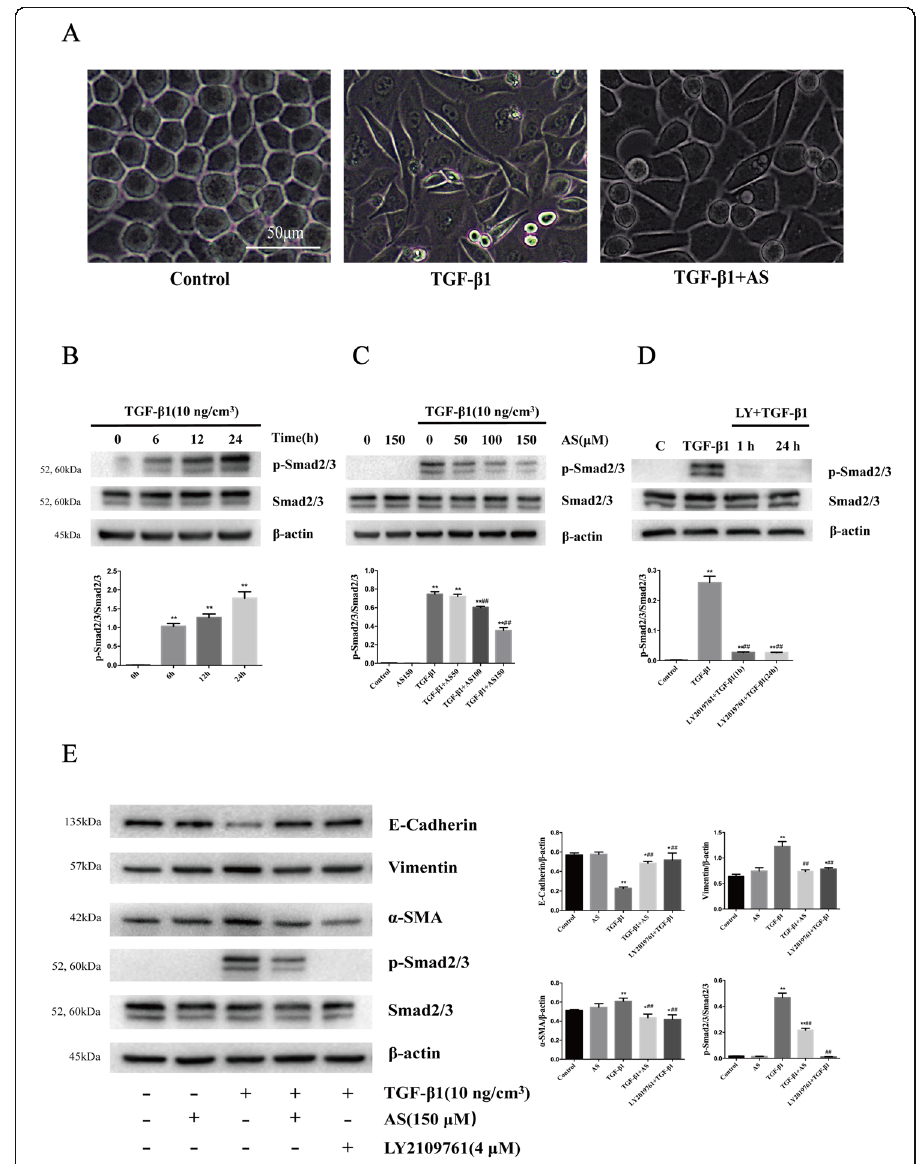
Fig. 3 Effect of asiaticoside on TGF- β 1-induced activation of Smad2/3 and MMT in HPMCs. Notes: (A) After treatment with TGF- β 1 (10ng/cm 3 ) or/and asiaticoside (150 μ M), the morphologic alterations of HPMCs were observed using a microscope (scale bar=50 μ m). (B) HPMCs were treated with TGF- β 1 (10ng/cm 3 ) for various times (0, 6, 12, 24h) and subjected to immunoblot for Smad-related proteins. (C) HPMCs were treated with asiaticoside at various concentrations (0, 50, 100, 150 μ M) with or without TGF- β 1 (10ng/cm 3 ) treatment for 24 h. The expression of Smad2/3 and p-Smad2/3 was detected by immunoblotting. (D) Immunoblot showed relative levels of Smad2/3 phosphorylation at 1h and 24h post-treatment with LY2109761. (E) HPMCs were divided into a vehicle group, an asiaticoside group (treated with 150 μ M asiaticoside), a TGF- β 1 group (treated with 10ng/ cm 3 TGF- β 1), a TGF- β 1+asiaticoside group (treated with 150 μ M asiaticoside +10ng/cm 3 TGF- β 1) and a LY2109761+TGF- β 1 group (pretreated with LY2109761 at 4 μ M 1h prior to 10ng/cm 3 TGF- β 1). After incubation for 24h, immunoblot was performed to detect relative proteins. β -actin was used as a loading control. The densitometric analysis of the expression of MMT markers, Smad2/3 and p-Smad2/3 are shown as unique figures. Data are expressed as mean±SEM, * p <0.05 vs. control; ** p <0.01 vs. control; #p<0.05 vs. TGF- β 1 treatment; ##p <0.01 vs. TGF- β 1 treatment. Abbreviations: AS, asiaticoside; TGF- β 1, transforming growth factor- β 1; LY, TGF- β receptor kinase inhibitor (LY2109761); p-Smad2/3, phosphorylated